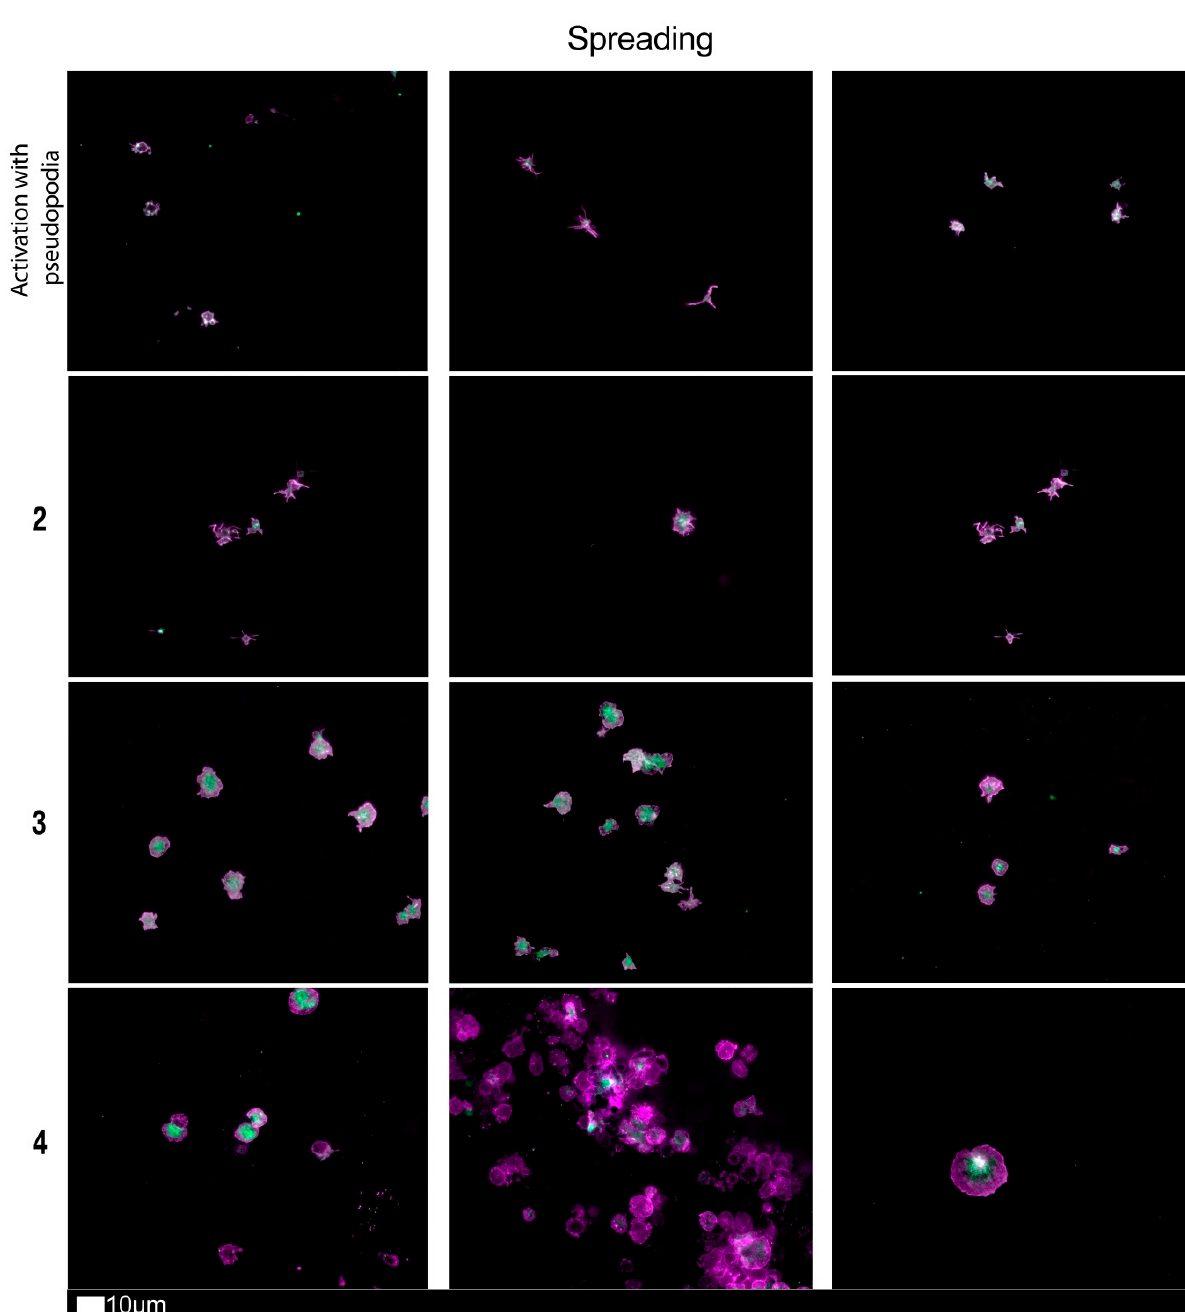
Figure 5. Fluorescence microscopy examples of the different stages of platelet activation and spreading. From healthy/control samples, with minimally activated platelets, seen as small round platelets with a few pseudopodia visible due to contact activation as seen in Stage 1, that progresses to the egg-shaped platelets, indicative of spreading and the beginning of clumping, as seen in Stage 4. Stage 1 to 4 is also used as a numerical scoring system, where a score of 1 is given for slight activation and pseudopodia formations, seen in a healthy individual, and a score of 4 is given for spreading.